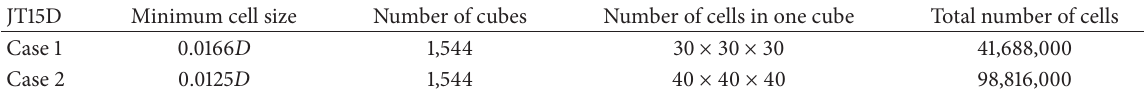
Table 4: Mesh information for the JT15D nacelle.